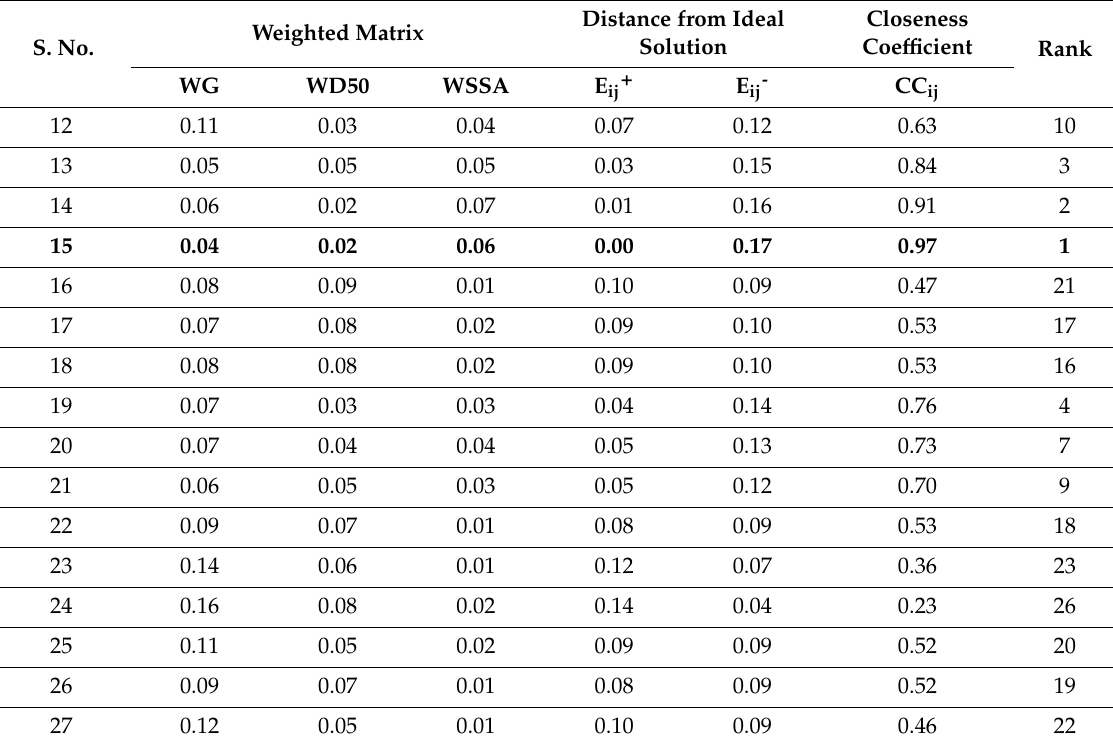
Table 5. TOPSIS evaluation for ball